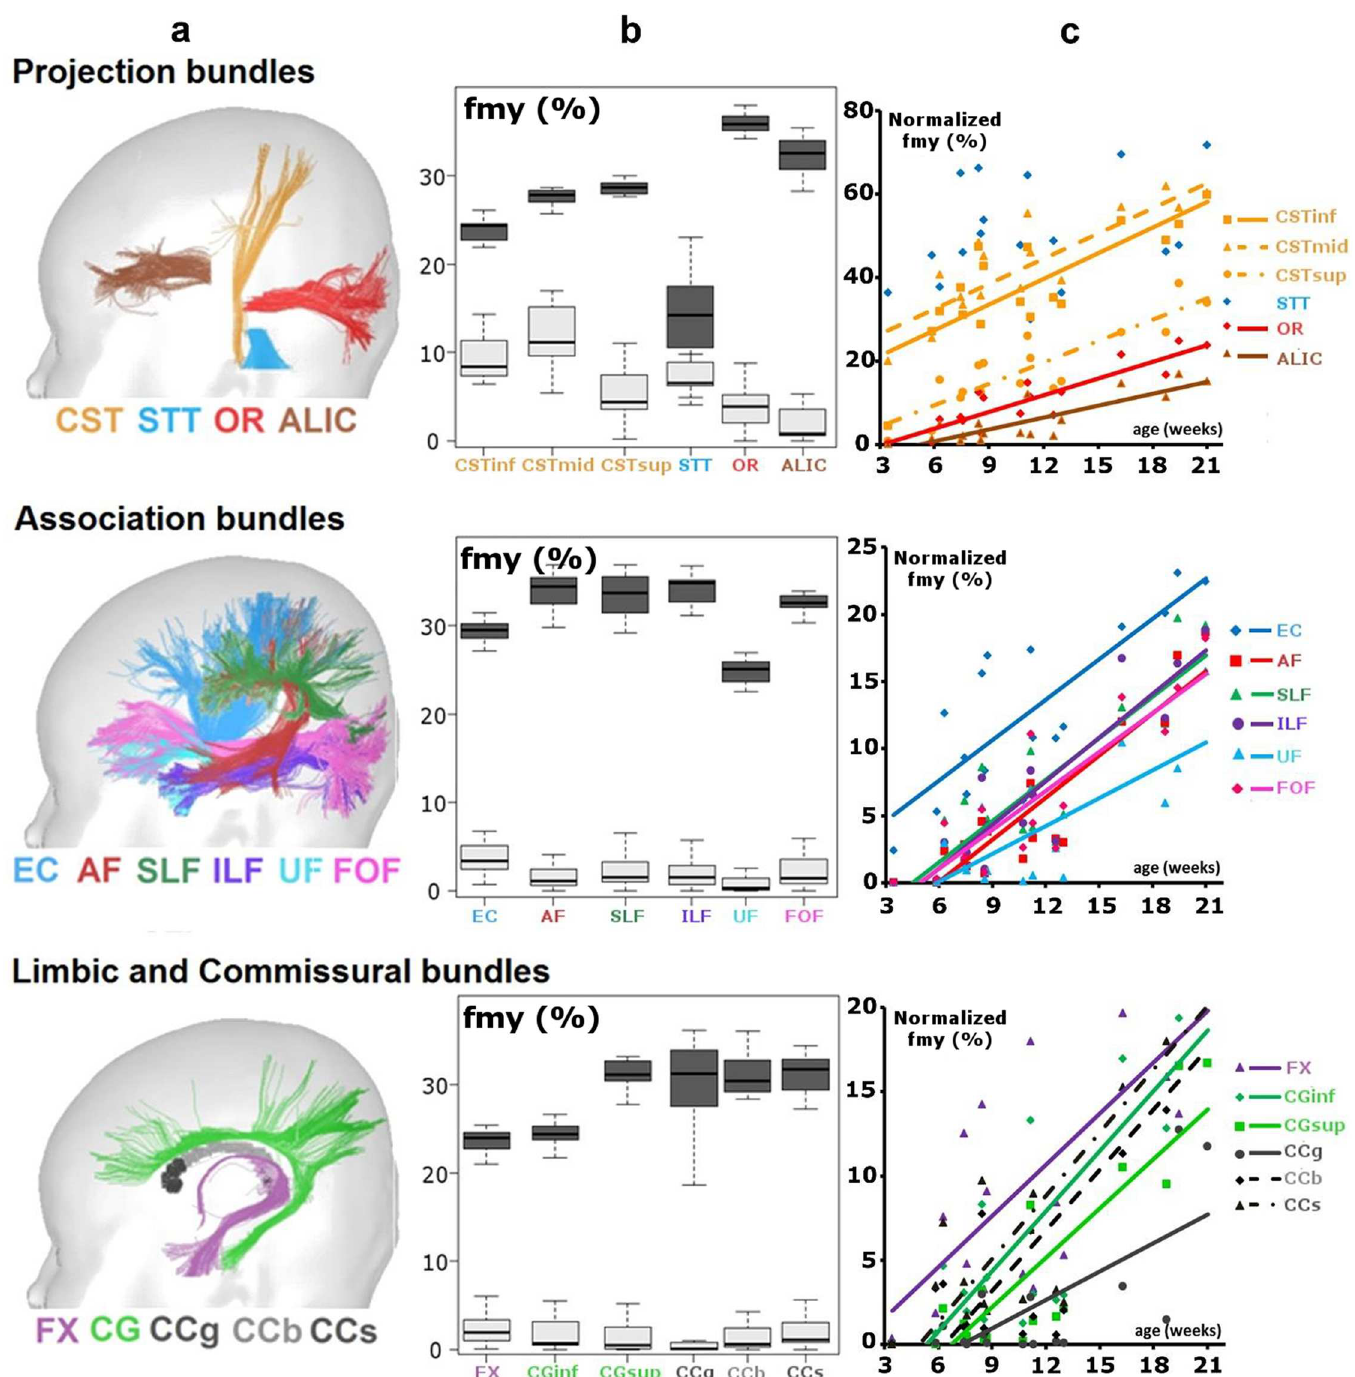
Fig 6. f my quantification across white matter bundles in infants and adults. (a) White matter bundles reconstructed with tractography (adapted from [42]). (b) f my values across bundlesin infants (light) and adults (dark). (c) Age-related changes in infants’ normalized f my values (in % of the mean adult values) for the same bundles. Lines show significant linear regressionswith age ( R 2 > 0.58, p < 0.015), for all bundlesexcept the spino-thalamic tract. Abbreviations: Projection bundles : cortico-spinal tract CST (inf—inferior, mid—middle, sup—superior portions), spino-thalamic tract STT, optic radiations OR, anterior limb of the internal capsule ALIC; Association bundles : external capsule EC, arcuate fasciculus AF, superior SLF and inferior ILF longitudinal fascicles, uncinate fasciculus UF, fronto-occipital fasciculus FOF; Limbic and Commissural bundles : fornix FX, inferior CGinf and superior CGsup parts of the cingulum;corpus callosum: genu CCg, body CCb and spleniumCCs.